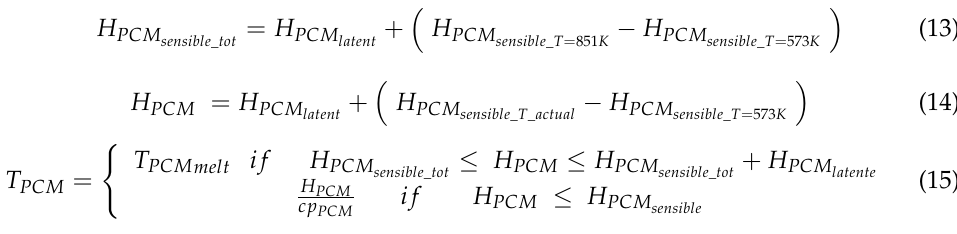
Table 5. Boundary conditions related to (11) and (12).